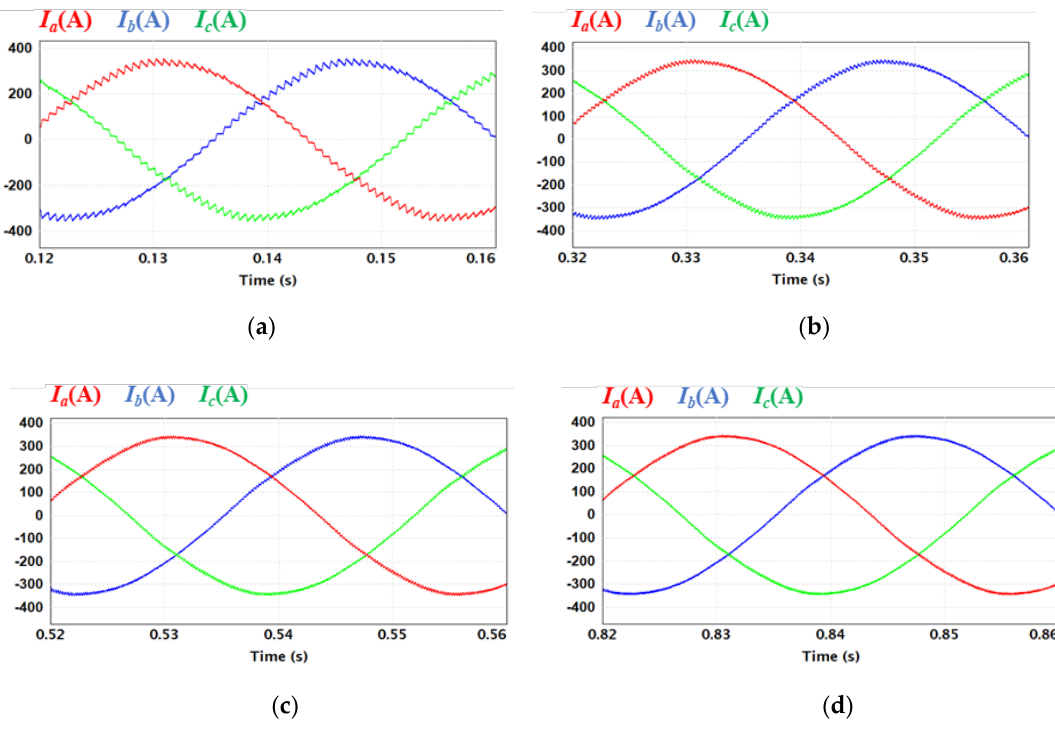
Figure 6. Three-phase current waveforms depending on f sw at 400 r/m: ( a ) 750 Hz; ( b ) 1500 Hz; ( c ) 2250 Hz; ( d ) 3000 Hz.